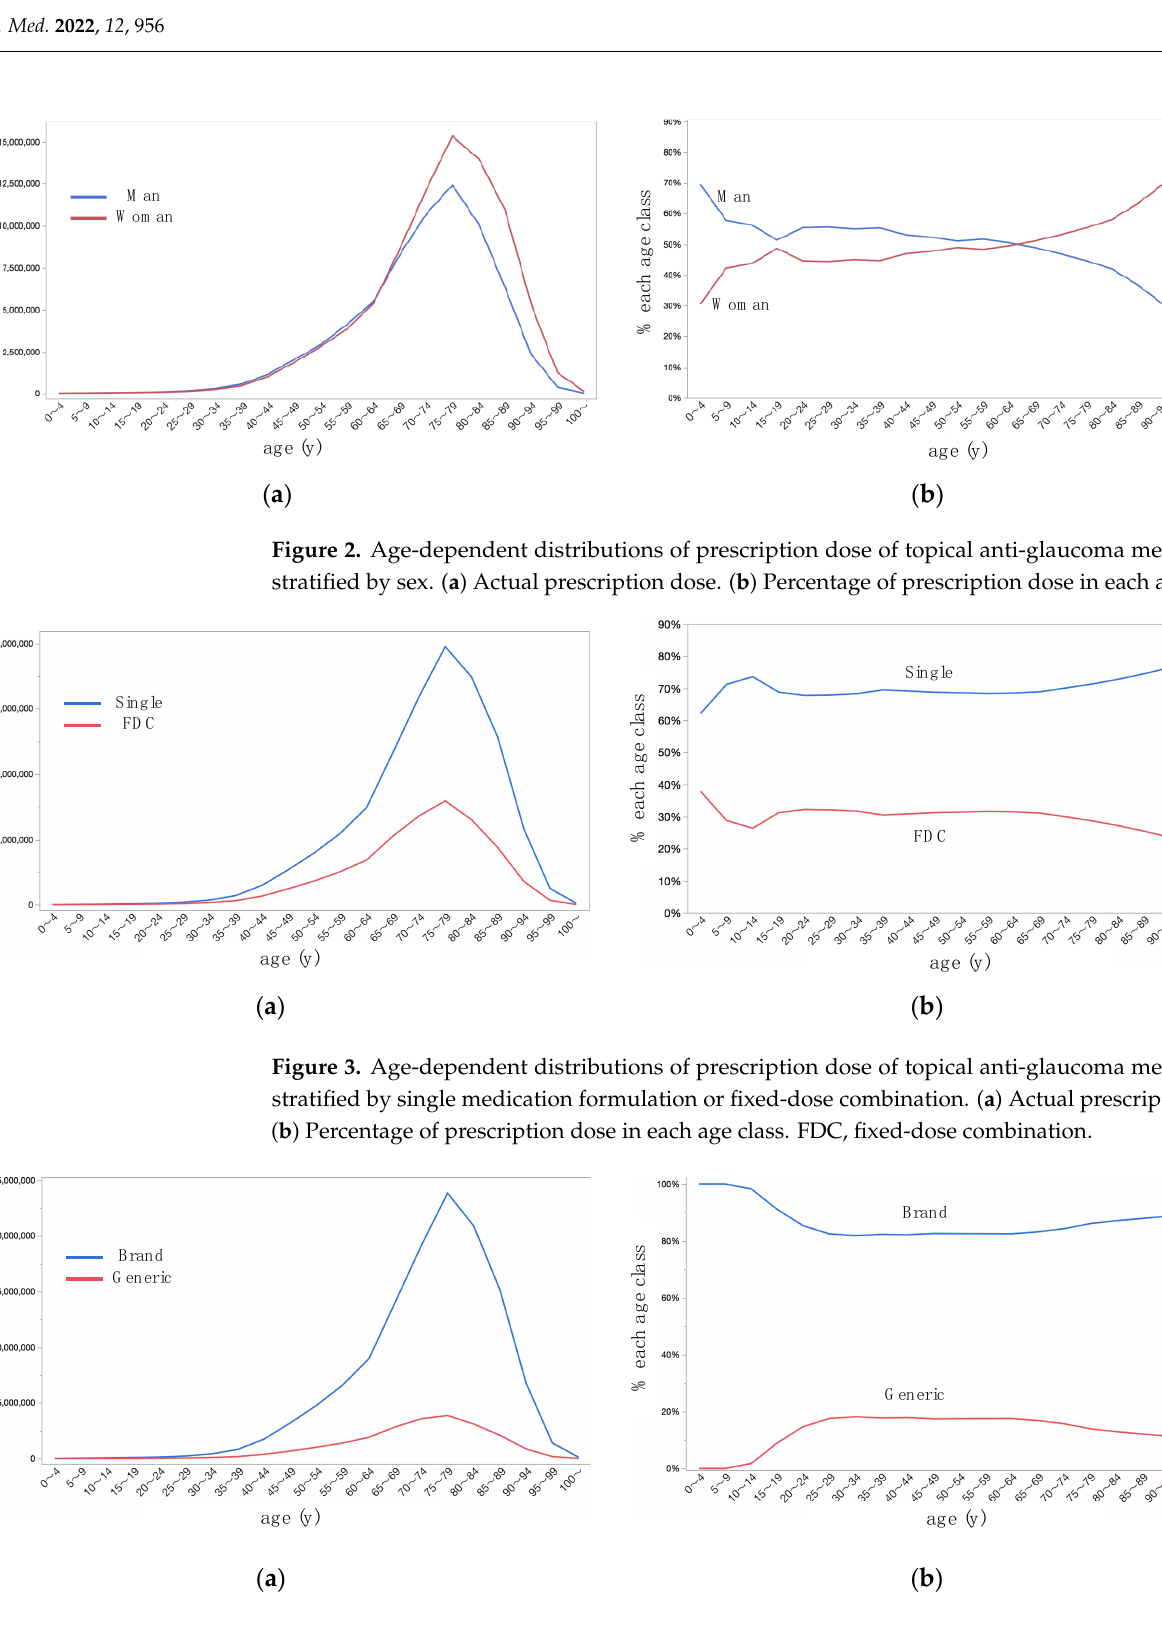
Figure 4. Age-dependent distributions of prescription dose of topical anti-glaucoma medications stratified by brand-name or generic. ( a ) Actual prescription dose. ( b ) Percentage of prescription dose in each age class.